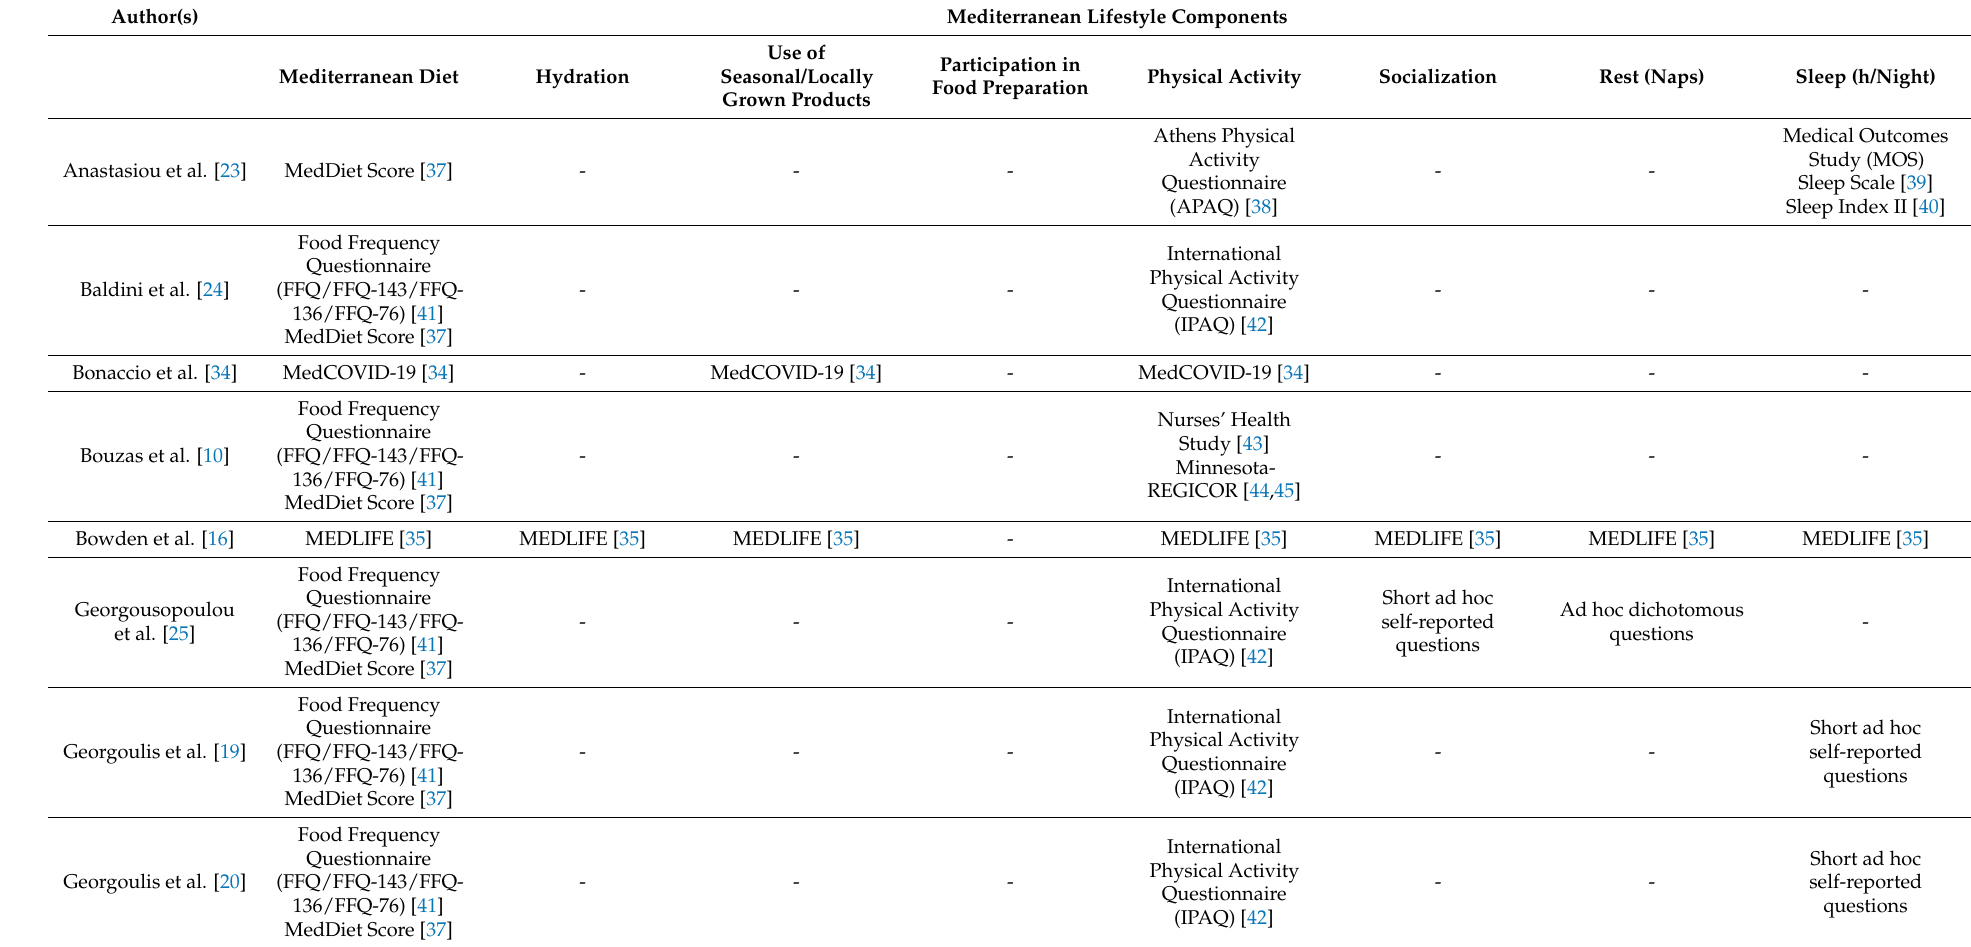
Table 5. Assessment tools used to analyze MLS